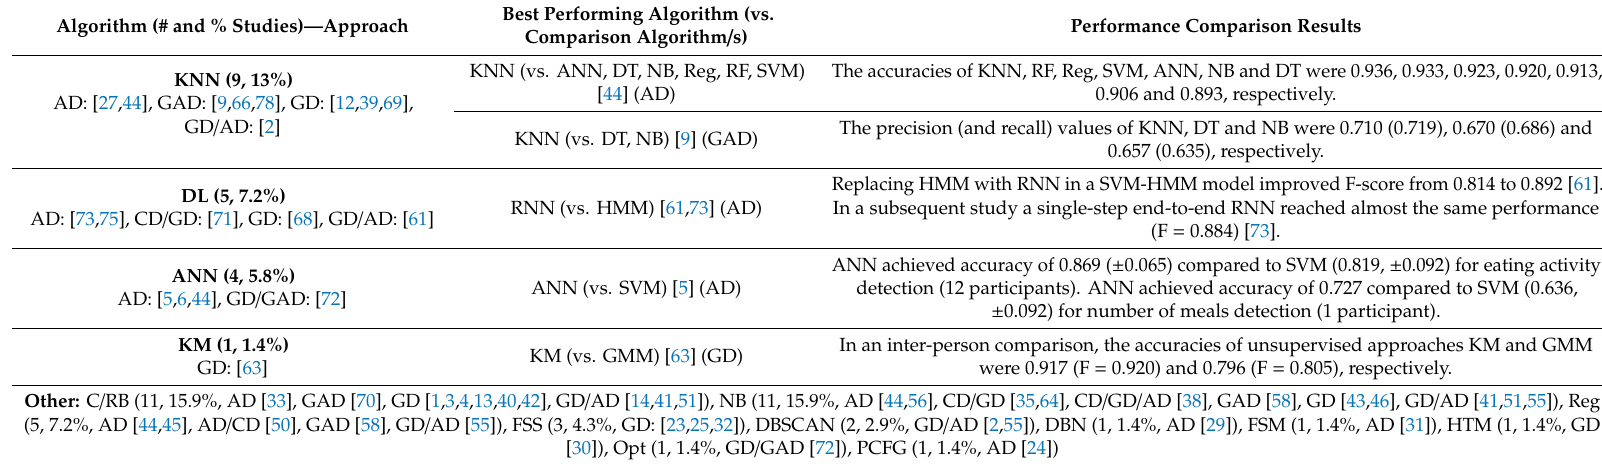
Algorithm (# and % Studies)—Approach